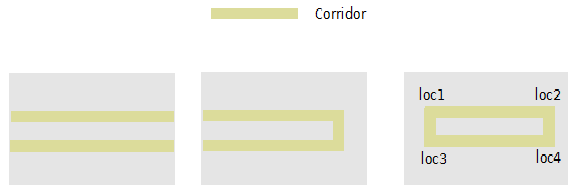
Figure 8. Variations of triple loaded horizontal access system